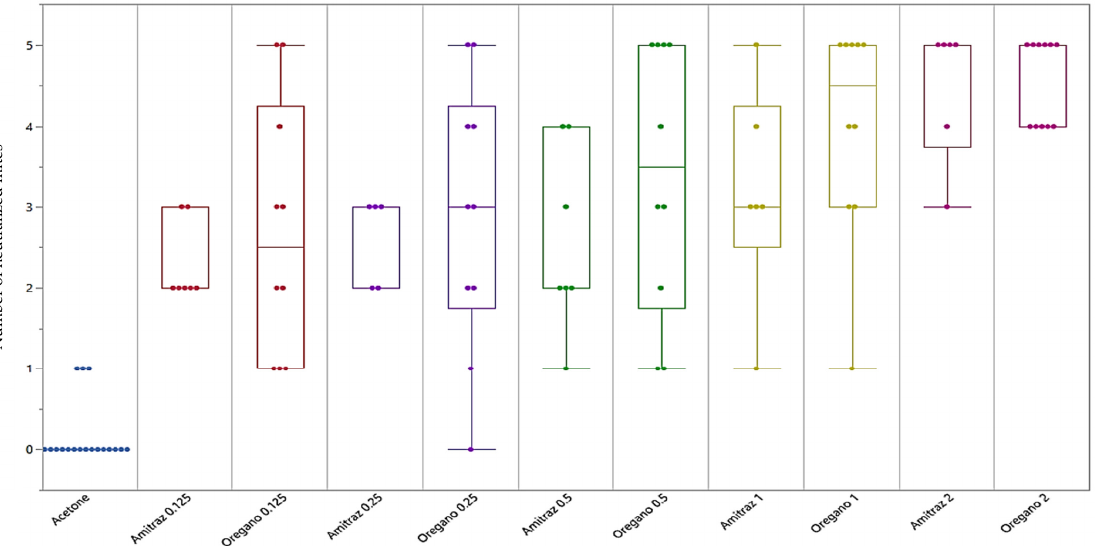
Figure 1. Representation of the effect of Oregano ( O. heracleoticum ) essential oil tested on mites, at a concentration of 0.125 mg/mL ( p = 0.0058), 0.25 mg/mL ( p = 0.0019), 0.5 mg/mL ( p ≤ 0.001), 1 mg/mL ( p ≤ 0.001), and 2 mg/mL ( p ≤ 0.001), compared to the negative control (Acetone). The comparison of the negative control with the positive control retrieved the following results (Amitraz; 0.125 mg/mL, p = 0.1665; 0.25 mg/mL; p = 0.140; 0.5 mg/mL, p = 0.052, 1 mg/mL, p = 0.0068 and 2 mg/mL, p ≤ 0.001). p -values were calculated with Dunn’s Multiple Comparison with Bonferroni correction. Table 2. V. destructor neutralized percentage and SD (±) after the treatment with O. heracleoticum essential oil, acetone and Amitraz. Concentration Oregano Acetone Amitraz (mg/mL) (O. heracleoticum) (− control) (+ control) 0.125 54 ± 31.3 45.7 ± 9.8 0.25 58 ± 33.3 52 ± 11 3.16 ± 7.5